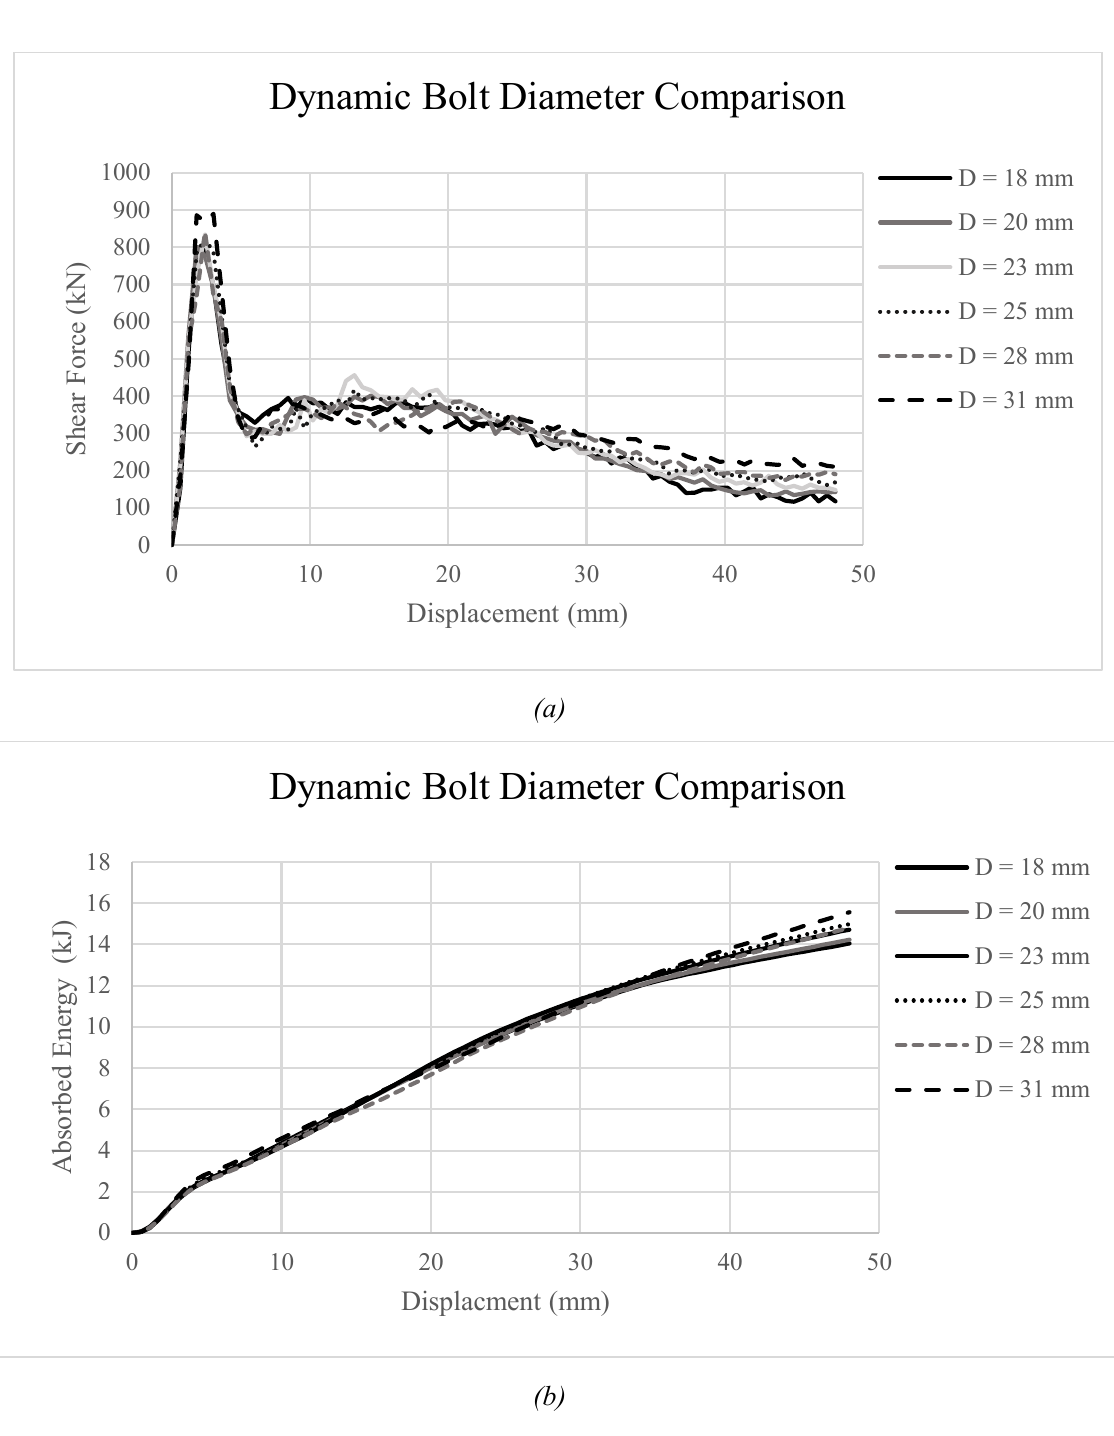
Figure 20. Bolt diameter comparison of ( a ) force vs. displacement and ( b ) absorbed energy vs. dis ‐ placement.